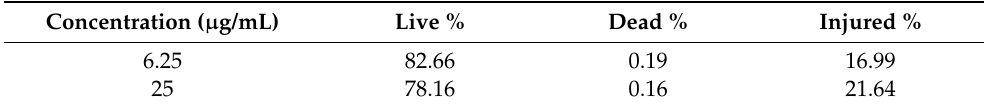
Table 1. Population Distribution of Cells Assay via a Live/dead Assay in Flow Cytometry in Response to MPA-CdSe/ZnS QD